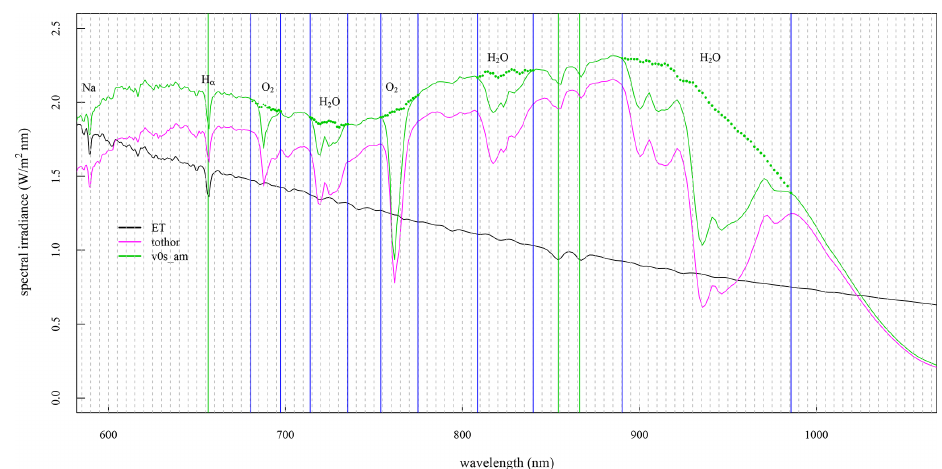
Figure 5. An illustration of the V 0 interpolation over strong O 2 and H 2 O molecular bands, using Eq. (1) (green dots are interpolated points). The black ET line is the extraterrestrial irradiance ( y axis label) for the mean distance to the Sun. The tothor and v0s_am are scaled to fit the plot.